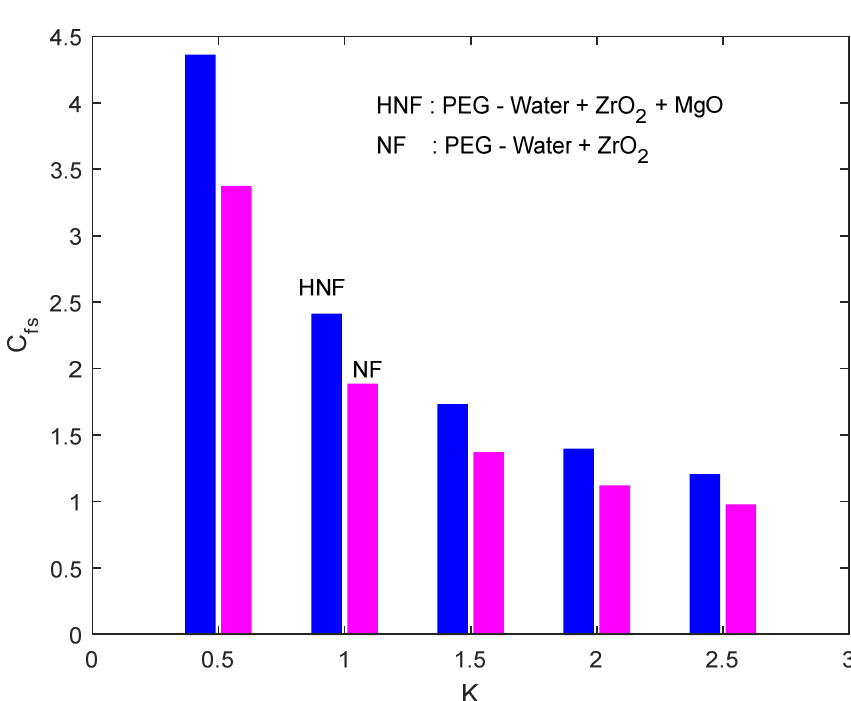
Figure 4. Effects on skin friction coefficient due to K .